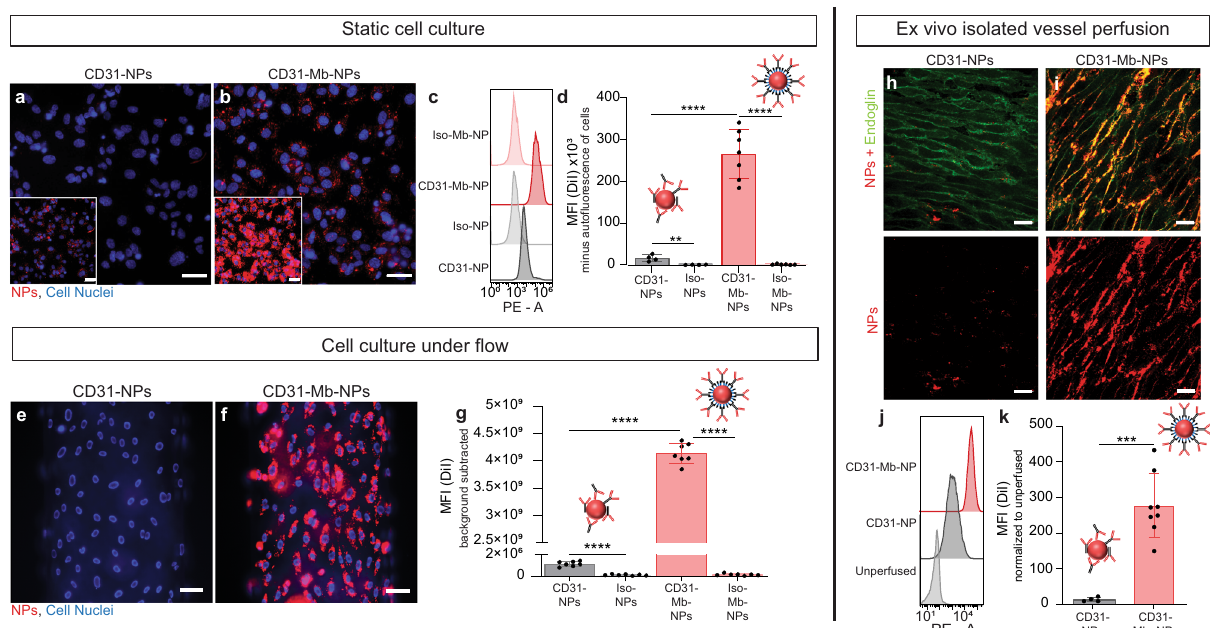
Fig. 2 | The monobody adapter improves binding potency in cultured endo- thelium and isolated human vessels. a , b Representative images of human umbilicalveinendothelialcells(HUVECs)instaticcellcultureafterincubationwith either CD31-Mb-NPs (PLA-PEG-DiI NPs) or CD31-NPs; nanoparticles (NPs) are dis- played in red. Scale bar is 50 µ m. Inset images are copies of the larger image, displayed with a higher brightness to display CD31-NPs. c Representative histo- grams and d summary data of the mean fl uorescence intensity (MFI) measured by fl ow cytometry of HUVECs after incubation. Each data point represents the aver- aged MFI from fl uorescent NPs in three wells with 10,000 HUVECs captured/well ( n =at least four indpendent experiments). e , f Representative images of HUVECs grown in micro fl uidic chambers after CD31-NPs ( e ) or CD31-Mb-NPs ( f ) were delivered under fl ow. Scale bar is 50 µ m. g Summary data obtained from